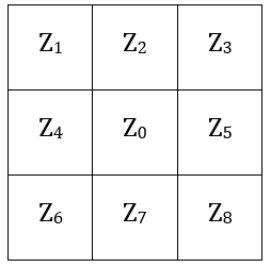
Figure 3. Pixel configuration used in the curvature calculation.